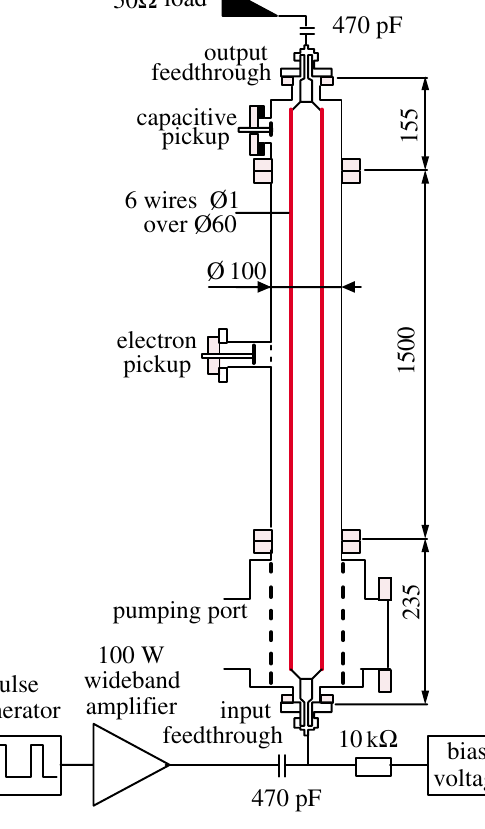
FIG. 1. (Color) TW multiwire chamber. The pulses coming from the signal generator are amplified by the wide band power amplifier. Each pulse, biased to ensure a positive voltage, travels along the six wires inside the chamber. The 50 (cid:3) rf load on the top avoids undesirable reflections. Capacitors on the top and the bottom isolate the dc currents inside the chamber. Lengths are given in